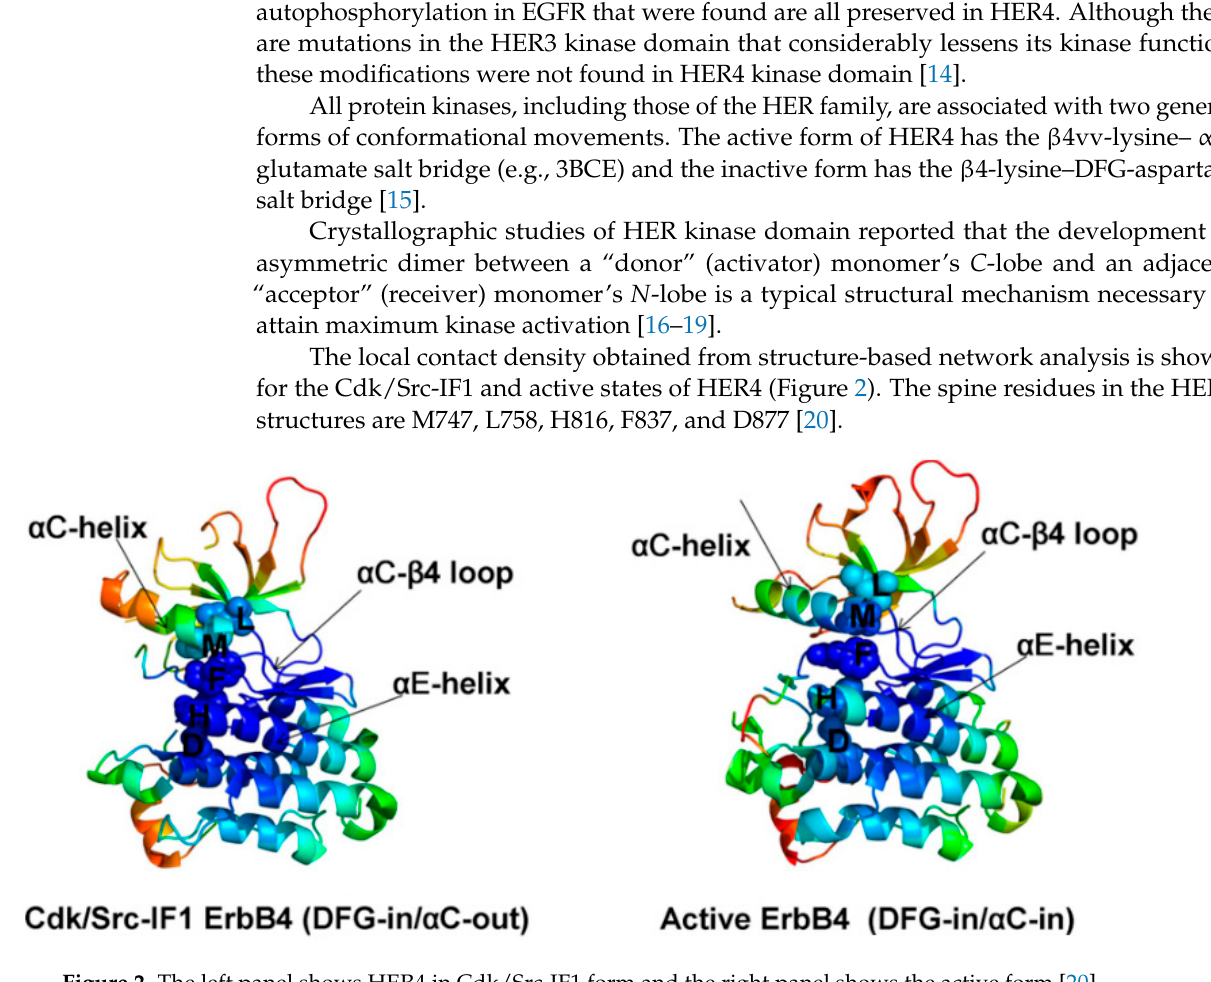
Figure 2. The left panel shows HER4 in Cdk/Src-IF1 form and the right panel shows the active form [20]. The residues of the R spine in EGFR (M766, L777, F856, D896, H835) and HER4 (M747, H816, F837, L758, D877) are closely related, showing the structural integrity of the HRD and DFG motifs, while the residues of the α C- β 4/ α C-helix interface (M766, L777 in EGFR and M747, L758 in HER4) label the boundary between high and low structural stability regions